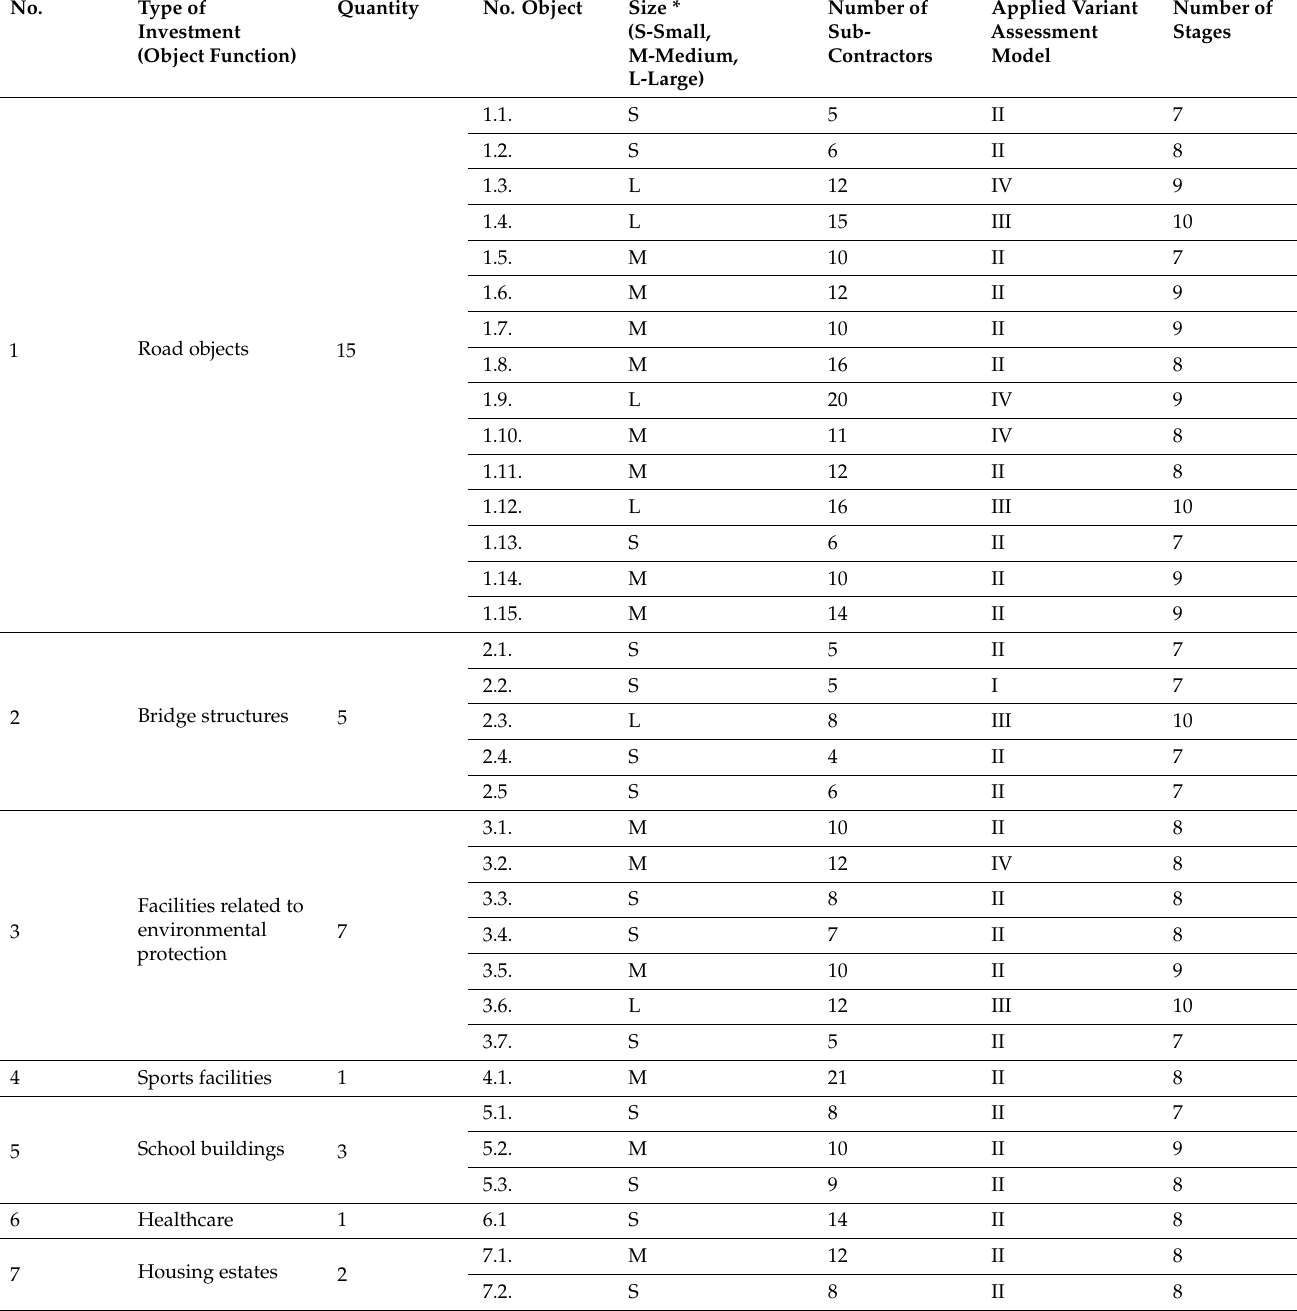
Table 3. Specification of the information gathered about decision models applied to select variants (Erection of civil